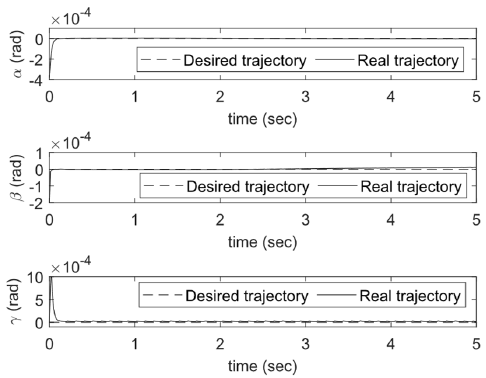
Figure 3. 3D orientation behavior of UR5 in the presence of the proposed controller.